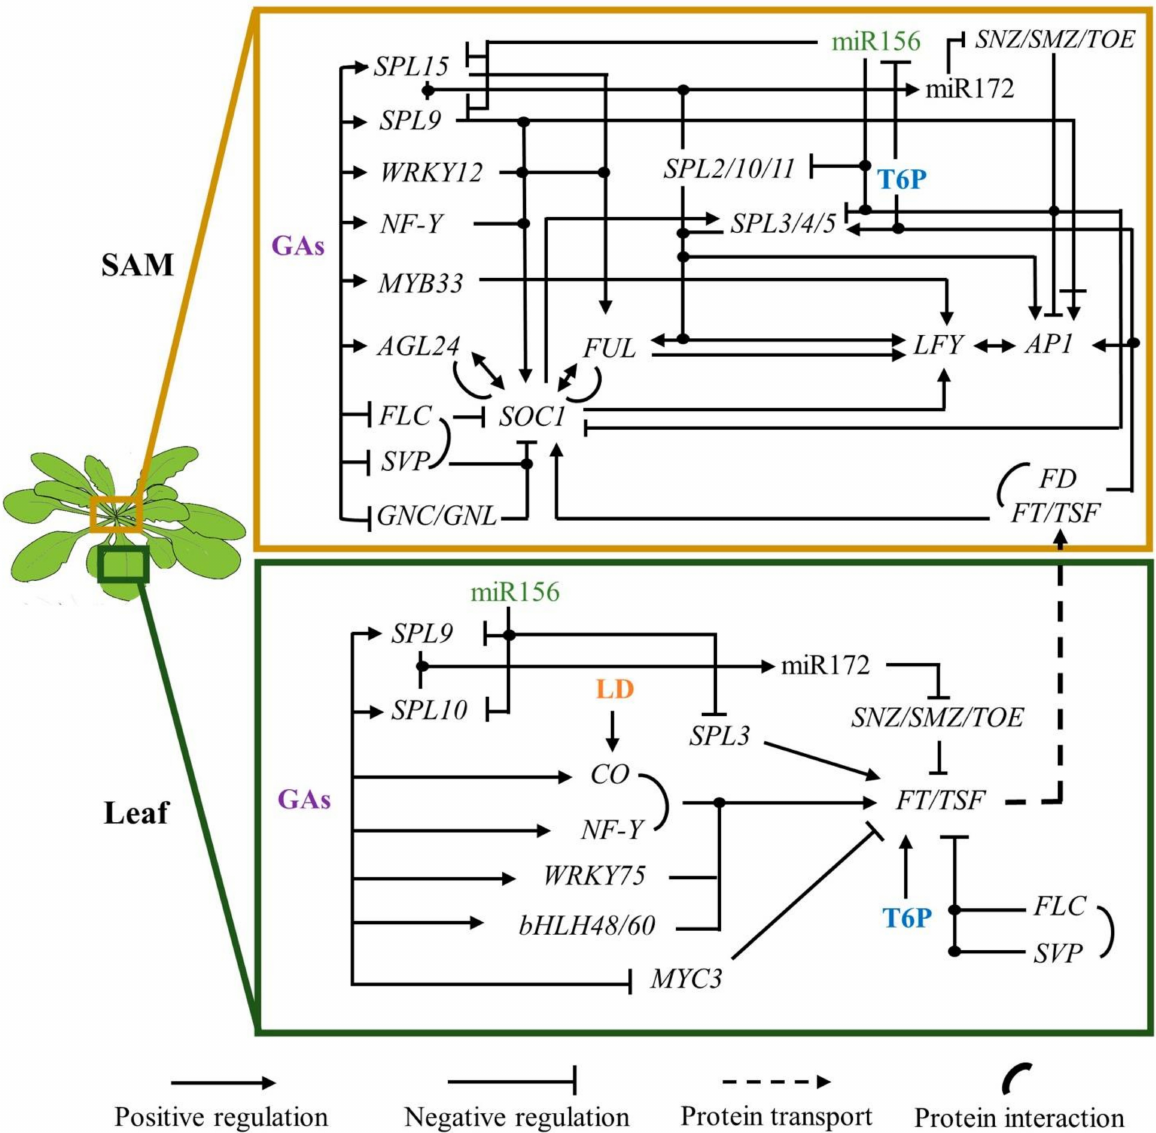
Figure 2. Gene regulatory network that promotes flowering transition in response to endogenous cues. Intricate regulations among the miR156-SPLs-miR172 module, and GAs and T6P signaling lead to FT induction in the leaves and LFY and AP1 at the flanks of the IM. MADS-box, SPLs, AP2-like, and WRKY TFs have a preponderant role in flowering transition. SPL9 dual regulation on AP1 (positive and negative bars), implies that in the presence of DELLAs, AP1 is induced, but GA treatment drastically reduced it. Line intersections with dots indicate molecular